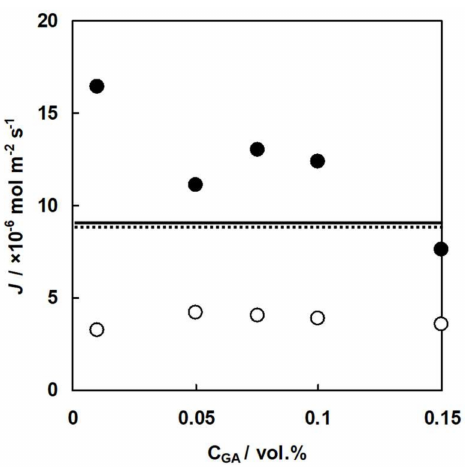
Figure 15. Flux of anions through A-HF membranes, J , of A-HF membranes as a function of GA concentration. Flux through A-HF membranes: solid circles, Cl − ions. Open ones, NO 3 − ions. Flux through AMX: solid line, Cl − ions. Dotted one, NO 3 − ions.